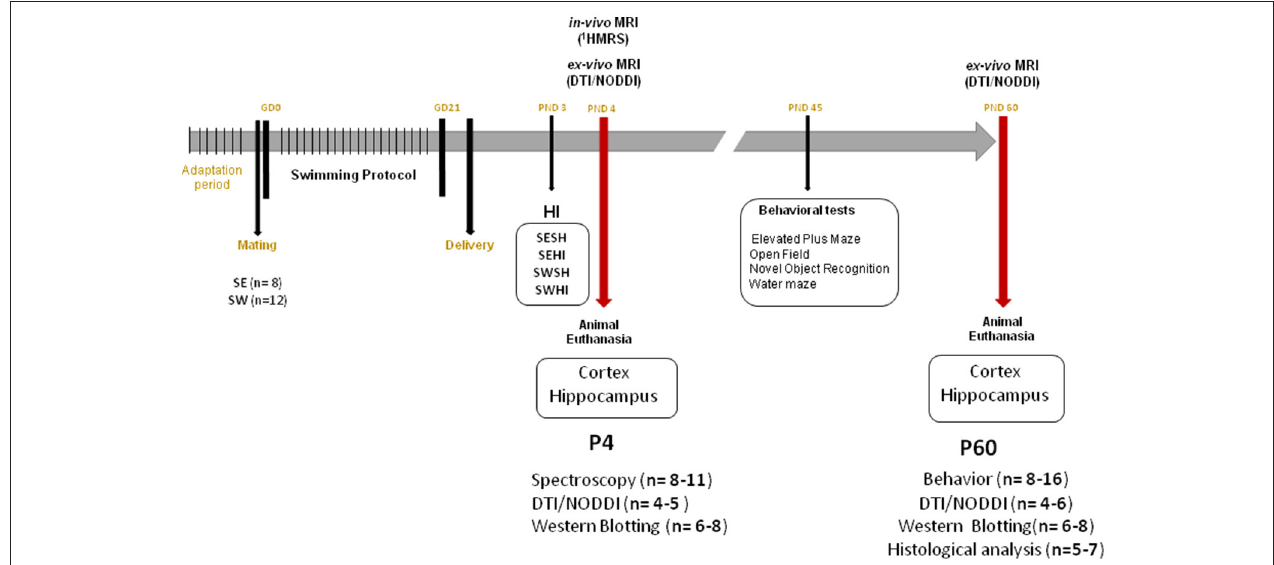
FIGURE 1 | Experimental timeline. GD, Gestational Day; HI, Hypoxia-Ischemia; PND, Postnatal day; DTI, Diffusion Tensor Imaging; NODDI, Neurite Orientation Dispersion and Density Index; SE, Sedentary; SW, Swimming.